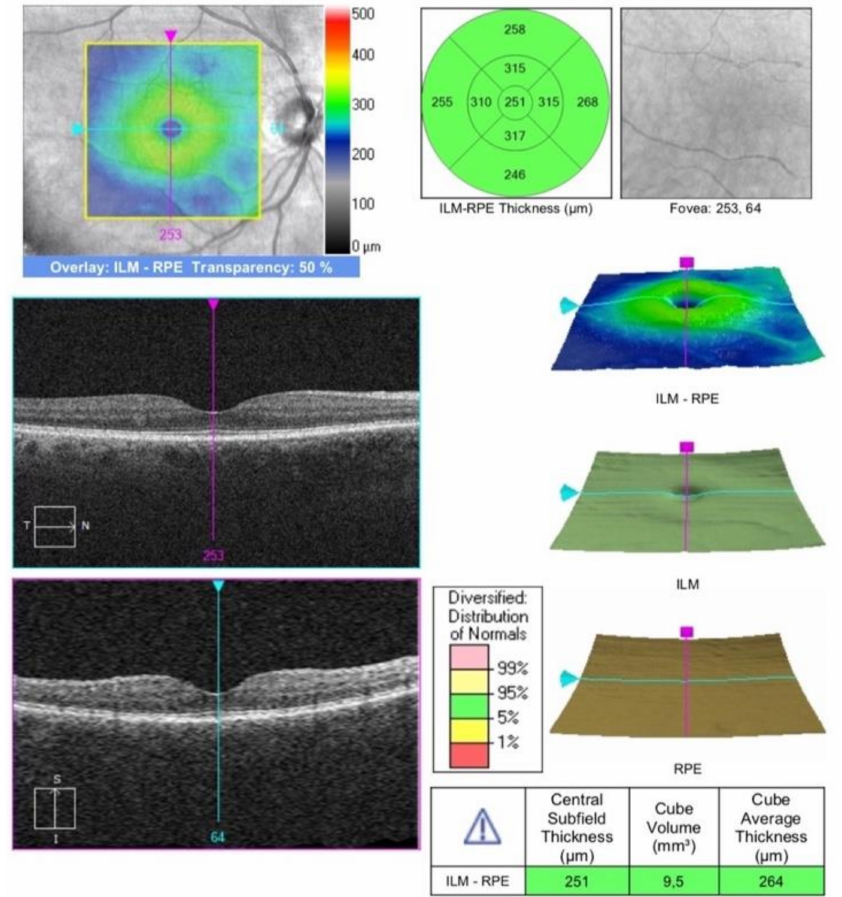
Figure 2. OCT macular